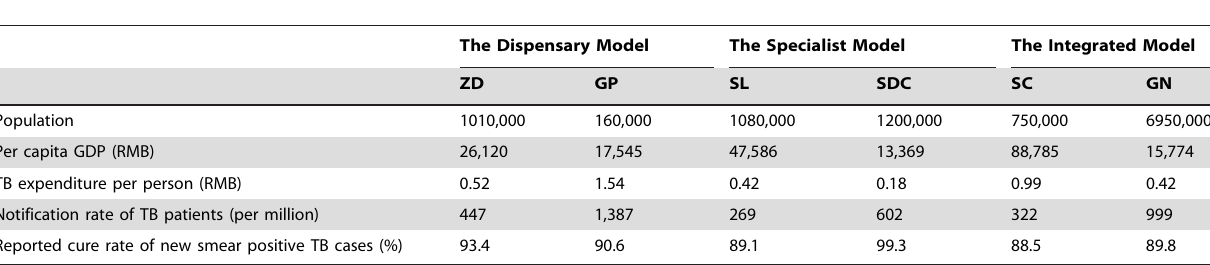
Table 1. The general social economic situation and health financing for TB in the three models (2007).